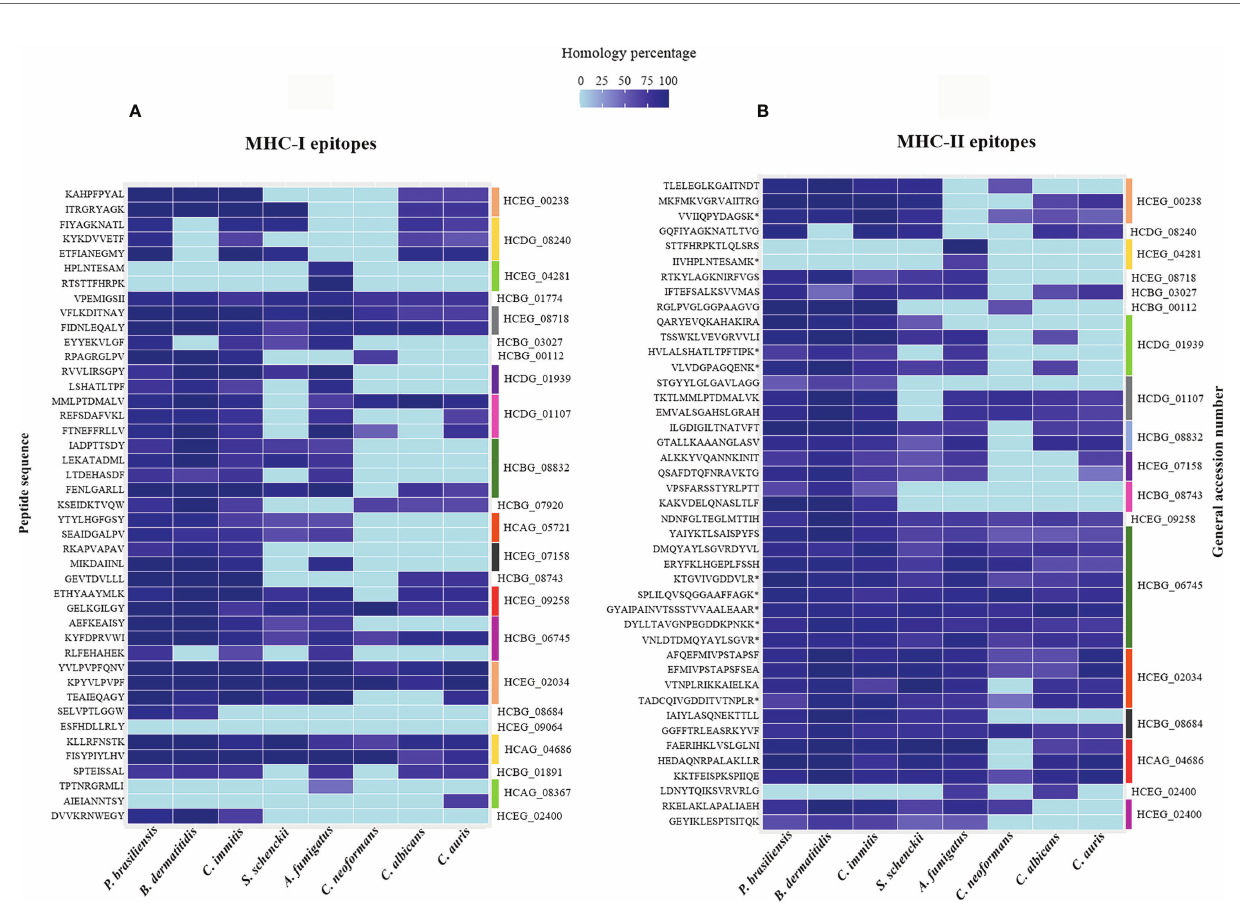
FIGURE 5 | Heat map of thepercentage of similarity ofepitopes derived from H. capsulatum antigenic proteins against P. brasiliensis , B. dermatitidis , C. immitis , S. schenckii , A . fumigatus , C. neoformans , C . albicans and C. auris . (A) Similarity percentage of 43 MHC I-binding epitopes derived from 23 antigenicproteins. (B) Similarity percentage of 43 MHC II-binding epitopes derived from 18 antigenicproteins. The analysiswere performed by BLAST-p algorithmand themap was plotted using software R package ggplot. HCEG_00238: 60S ribosomal proteinL27,HCDG_08240: 60S ribosomal protein L2, HCEG_04281: 60S ribosomal protein, HCBG_01774: 40S ribosomal protein S15, HCEG_08718: 6-Phosphogluconate dehydrogenase, HCBG_03027: 4-Hydroxyphenylpyruvate dioxygenase, HCBG_00112: Sm domain-containingprotein, HCDG_01939: Ribosomal protein L14, HCDG_01107: Peroxidase, HCBG_08832: HSP-60 like protein, HCBG_07920: Hsp70-likeprotein, HCAG_05721: Homogentisate 1,2-dioxygenase, HCEG_07158: H15 domain-containingprotein, HCBG_08743: Heat shock proteinSSC1, HCEG_09258: Glyceraldehyde-3-phosphate dehydrogenase, HCBG_06745: Fructose-bisphosphate aldolase, HCEG_02034: Enolase, HCBG_08684: Elongation factor 1-gamma, HCEG_09064: Citrate synthase, HCAG_04686: ATP- dependent molecular chaperoneHSC82, HCBG_01891: ATP synthase subunit alpha, HCAG_08367: Aldehydedehydrogenase, HCEG_02400: Aha1_N domain-containing protein.(*)Sequences of peptides obtained through themethod of immunoprecipitation that werenaturally presented bymurineBMDMsand